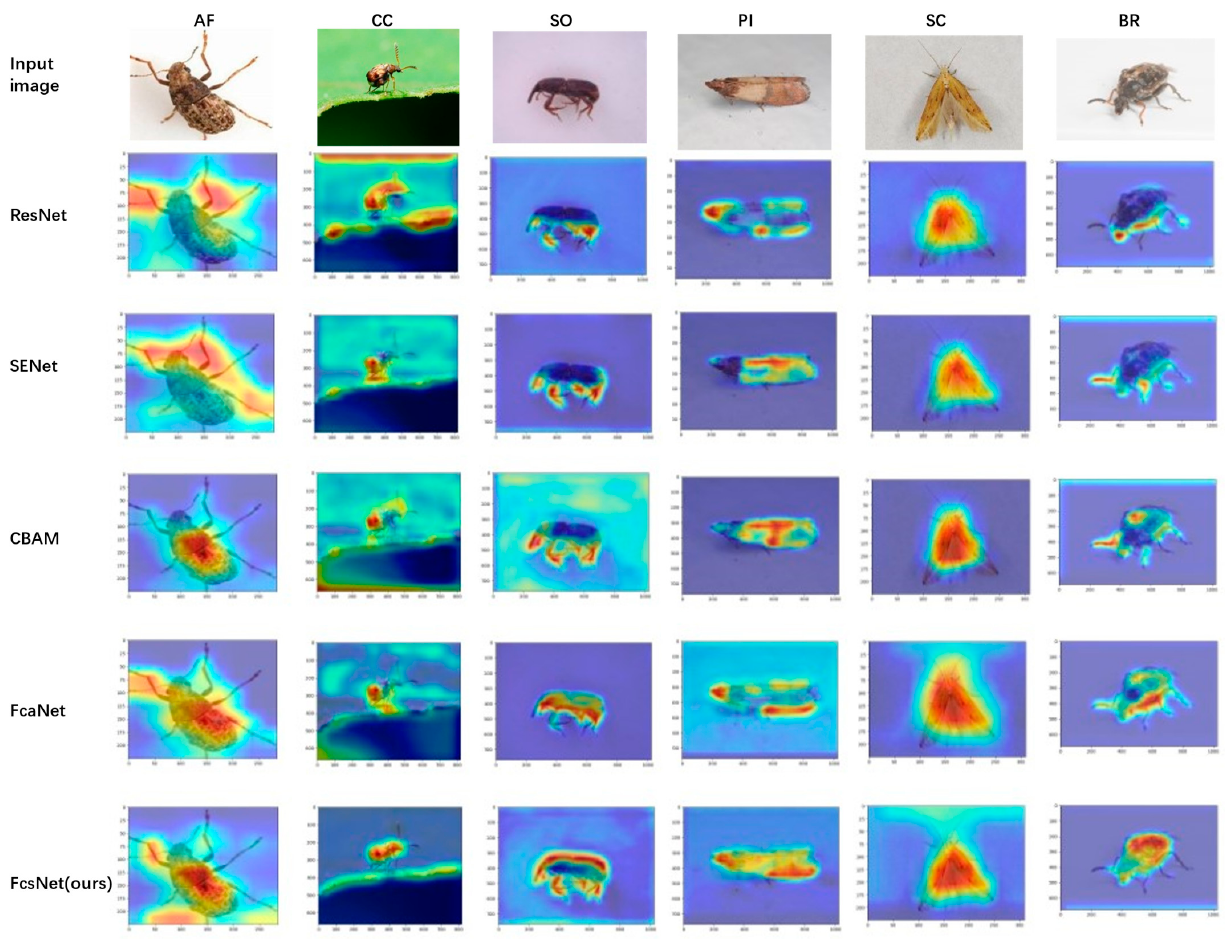
Figure 9. The Grad-CAM visualization results. We compared the visualization results from ResNet, SENet, CBAM, FcaNet and FcsNet, and calculated the gradient CAM visualization of the final convolution output.